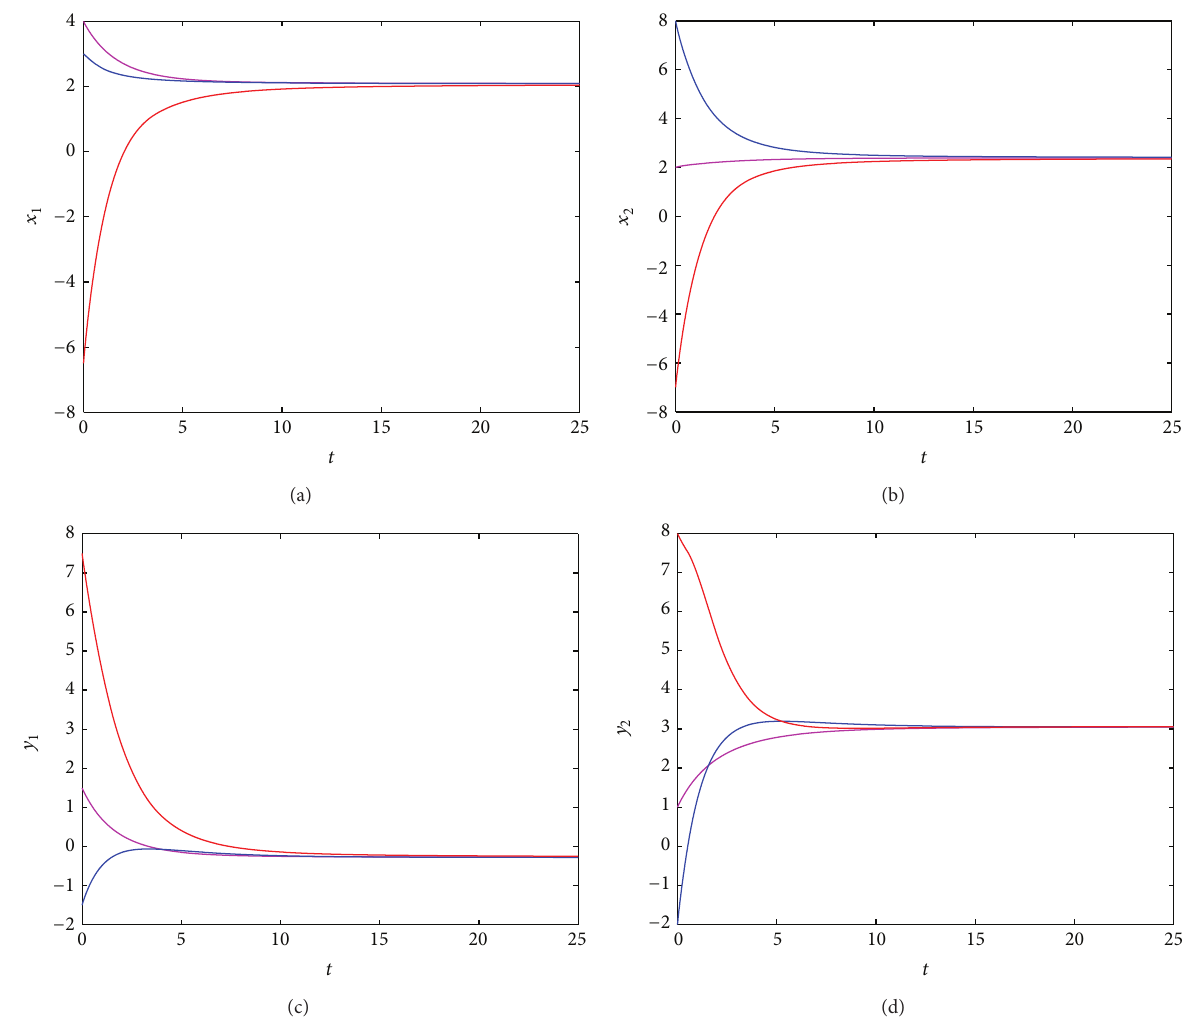
Figure 2: Transient states of the fractional-order BAM neural networks in Example 1 with 𝛼 = 0.95 , 𝜎 = 0 , and 𝜏 = 0.50 .